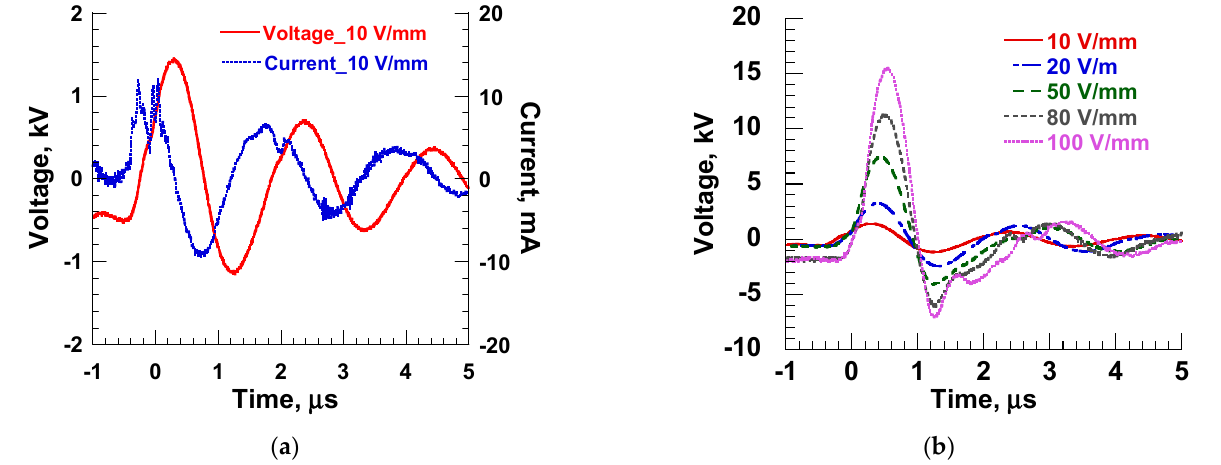
Figure 4. Output waveforms of applied voltage and current through the electrodes. ( a ) Typical applied voltage and current waveforms at 10 V/mm; ( b ) applied voltage waveforms for 10, 20, 50, 80, and 100 V/mm.